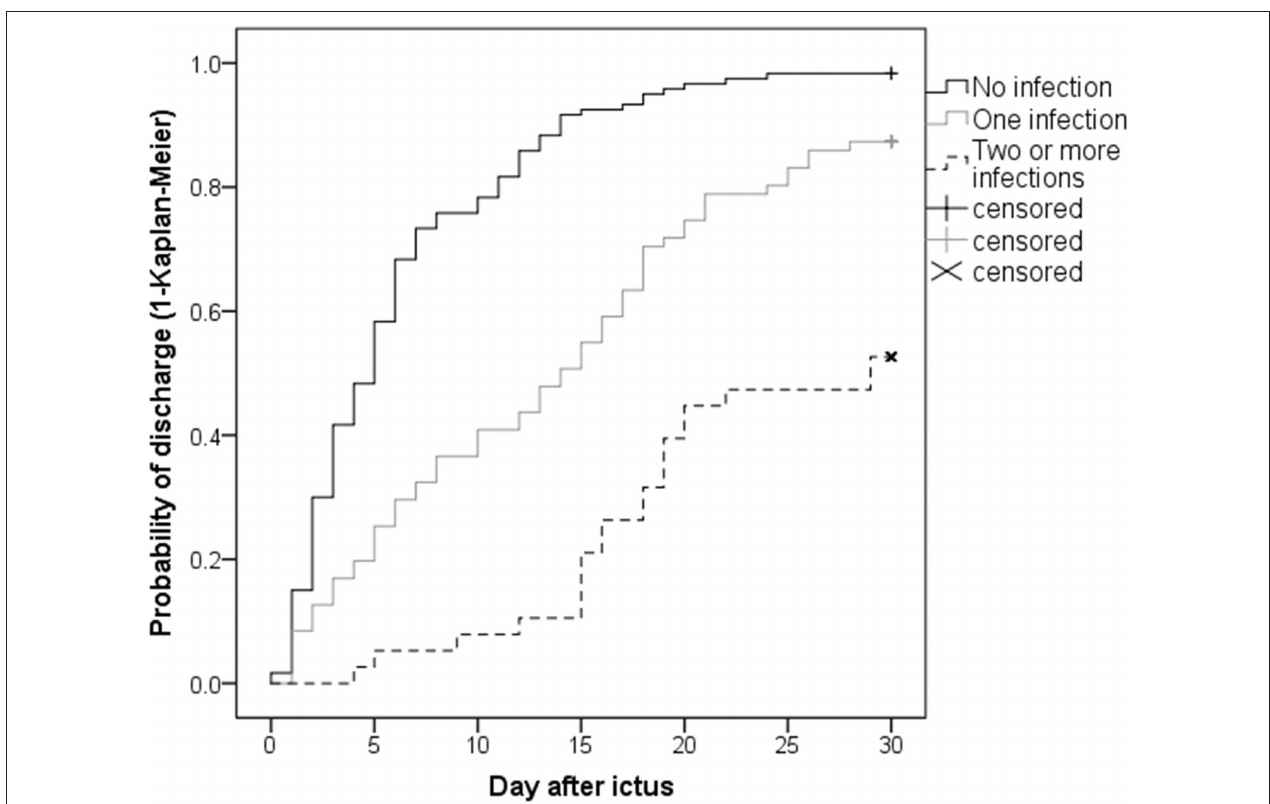
FIGURE 5 | Length of NICU stay: Patients without any infection had a median LOS of 5 days [IQR 2–8 days], patients suffering from one infection 14 days [IQR 5–21 days], while patients suffering from two or more infections stayed 29 days [IQR 16–44 days] at NICU. All patients staying longer than 30 days were censored at day